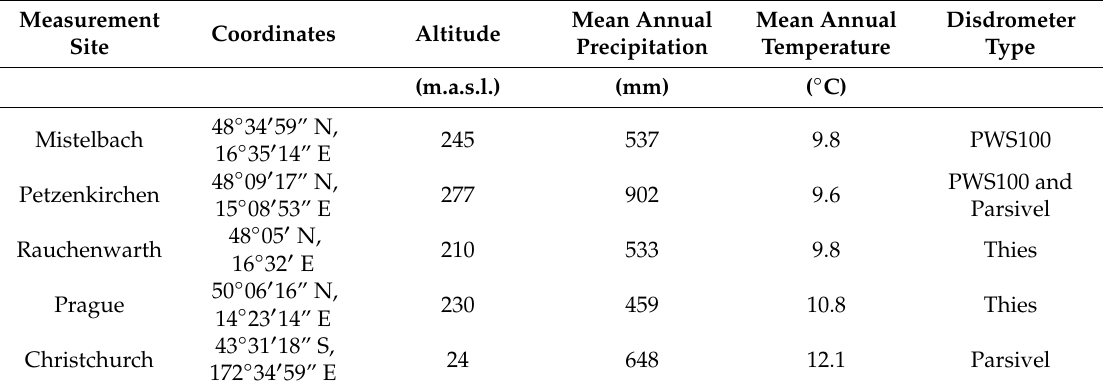
Table 2. Measurement site characteristics and disdrometer